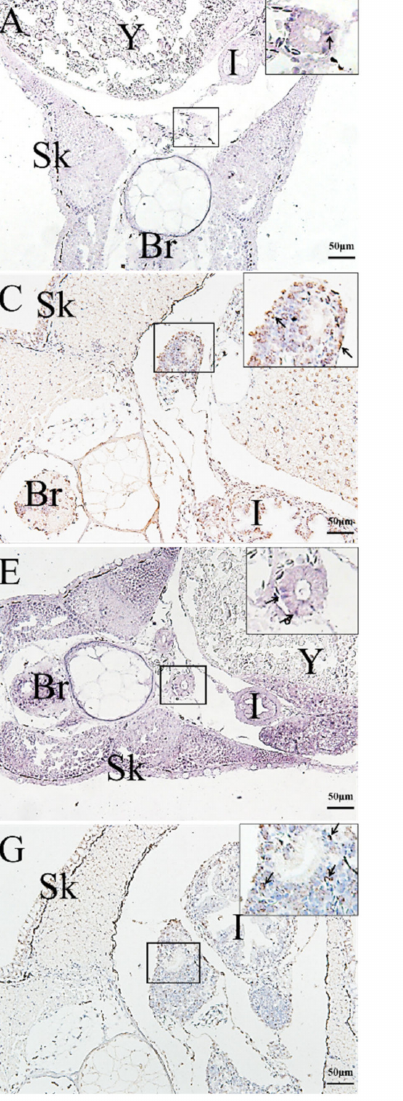
Figure 6. Expression of rags genes in the kidney at different developmental stages. Rag1 ( A – D ) and rag2 ( E – H ) expression was observed in the hematopoietic tissues of kidney. ( A , E ): 2 dph; ( B , F ): 6 dph; ( C , G ): 30 dph. ( D , H ): 45 dph. ( B , C , F , G ): DAB staining, ( A , D , E , H ): NBT/BCIP staining. Bars: 50 µ m. Arrow: rags signal. Br: brain. Y: yolk. I: intestine. Sk: